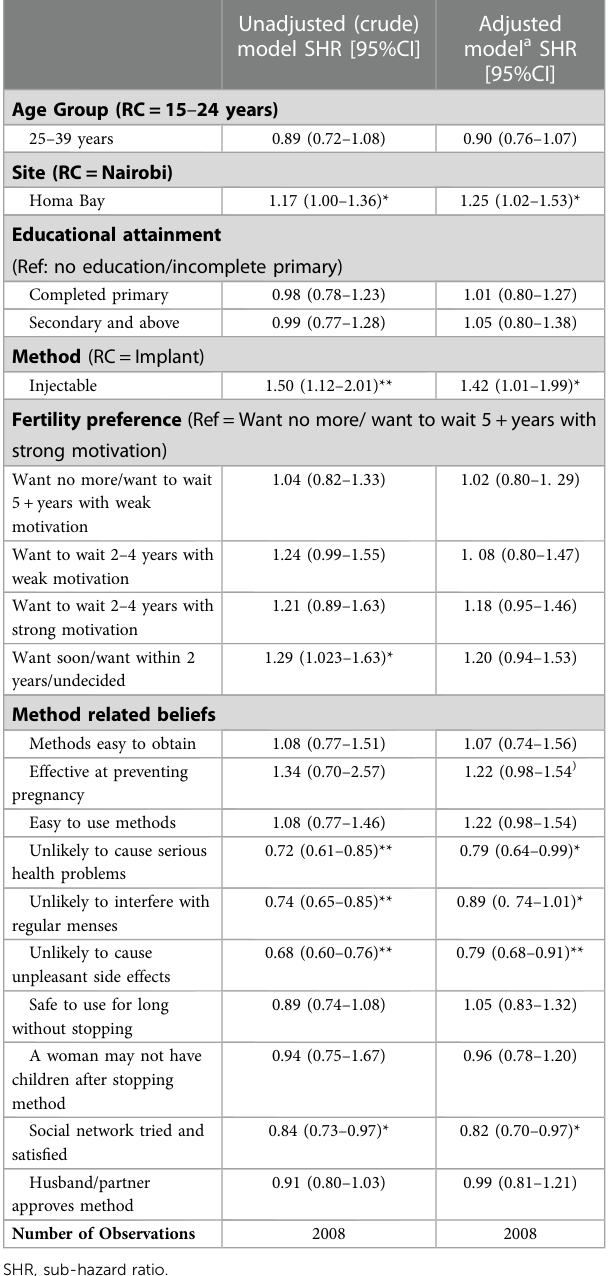
TABLE 5 Unadjusted (crude) and adjusted competing risk survival models predicting women ’ s probability of discontinuing implants or injectables during 12-month follow-up, Nairobi and Homa